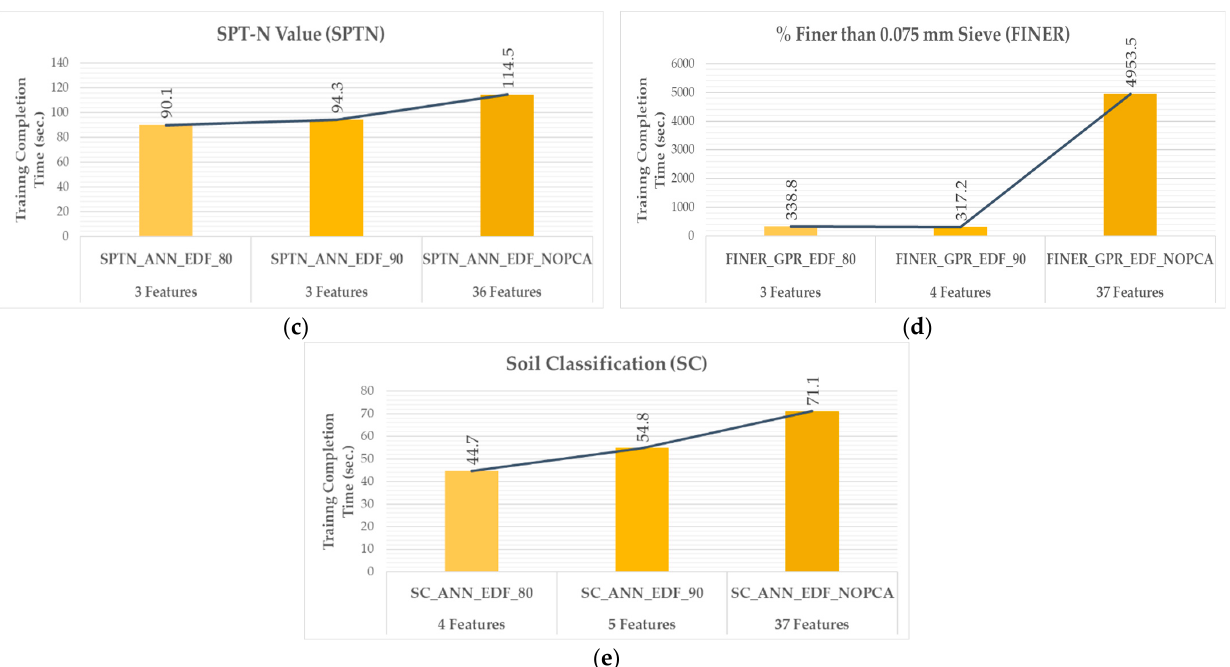
Figure 11. The number of features and training completion time of ( a ) GWL, ( b ) GWL, ( c ) SPTN, ( d ) FINER, and ( e ) SC models.